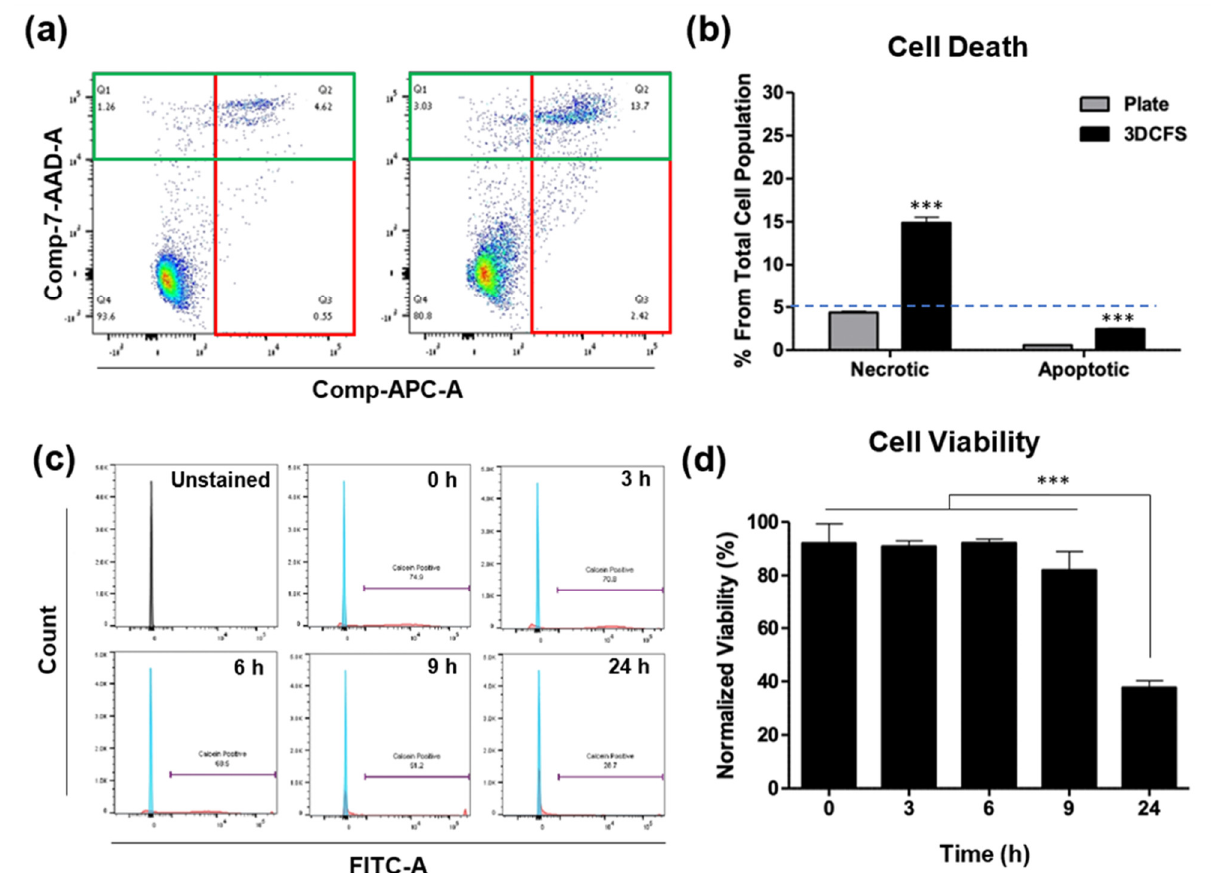
Figure 2. Identification of apoptosis, necrosis and cell viability. A375 cells were seeded and incubated both in static and floating condition for 24 h and underwent apoptosis assay using Annexin V and PI staining. ( a ) FACS’s scatter plot of cells in static conditions (left) and in floating conditions (right). The Annexin and PI positive cells are marked in green and red rectangles, respectively. ( b ) The results show that the percentage of both apoptotic and necrotic cells in static condition was less than 5%, while in floating condition, the percentage of apoptotic cells was under 5% and of necrotic cells approximately 15%. ( c , d ) Viability of A375 cells in the 3DCFS was measured at different time points over 24 h. ( c ) Cells were sampled at different labeled intervals, treated with calcein AM and underwent FACS analysis. ( d ) The results were normalized to a control measurement and show that the A375 cells kept their viability levels for as long as 9 h floating in the 3DCFS and decreased by approximately 50% after 25 h. p -value: *** ≤ 0.001.